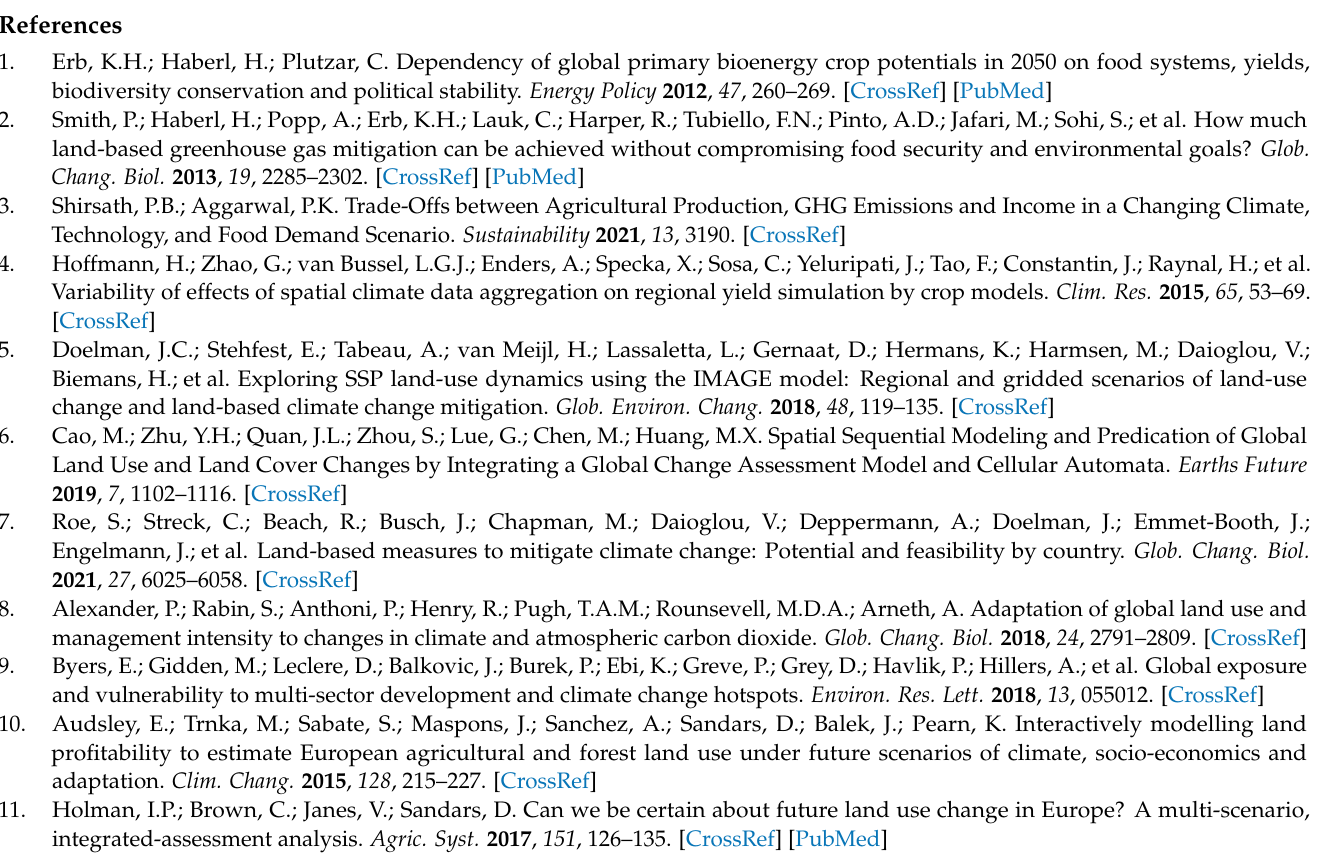
Figure A3. Mosaicked Landsat scene dates for the 2006 growing season.